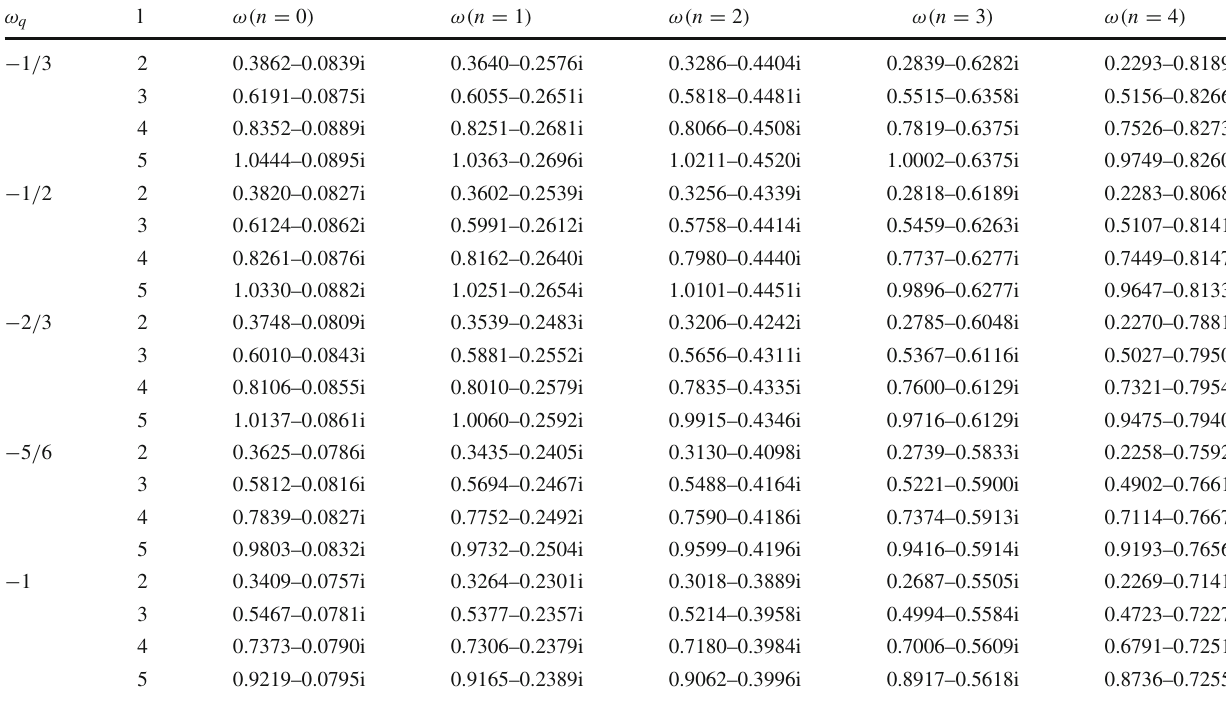
Table 2 Quasinormal frequencies of gravitational perturbation of regular Bardeen black hole surrounded by quintessence for β = 0 . 5 and c = 0 . 01